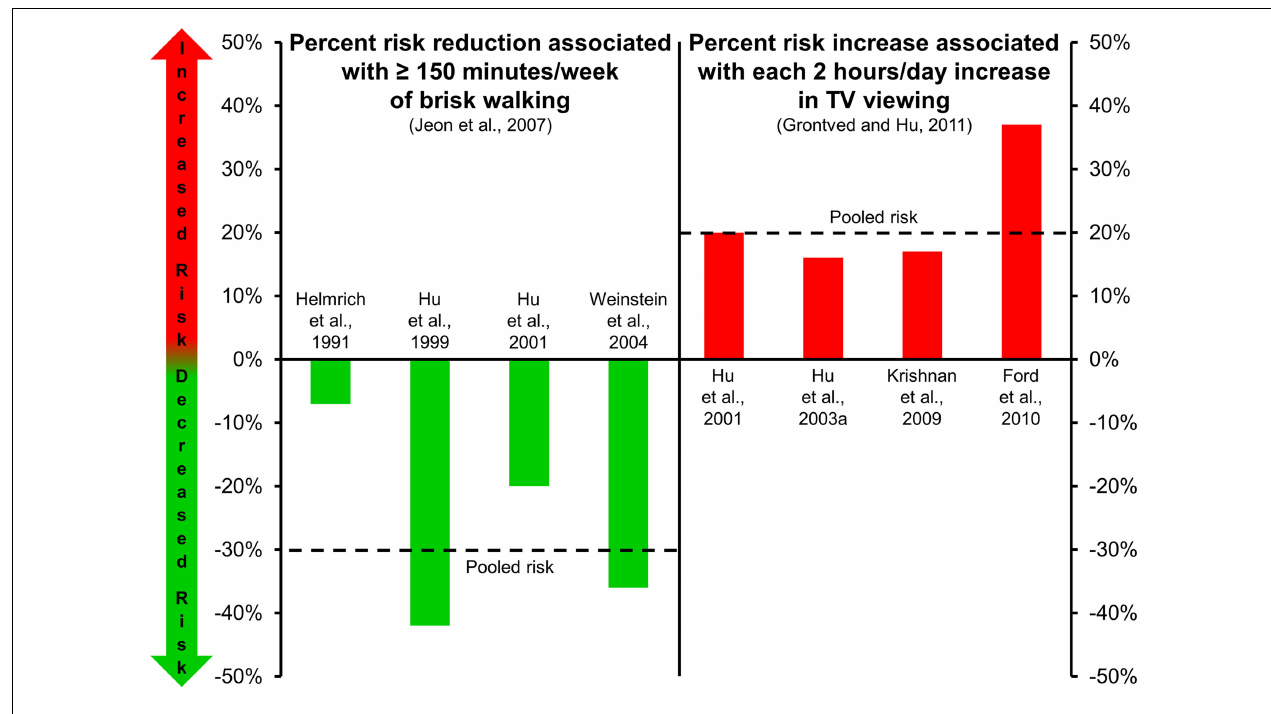
studies included. Risk reduction associated with ≥ 150min/week of brisk walking is in comparison to risk level associated with minimal amounts of weekly